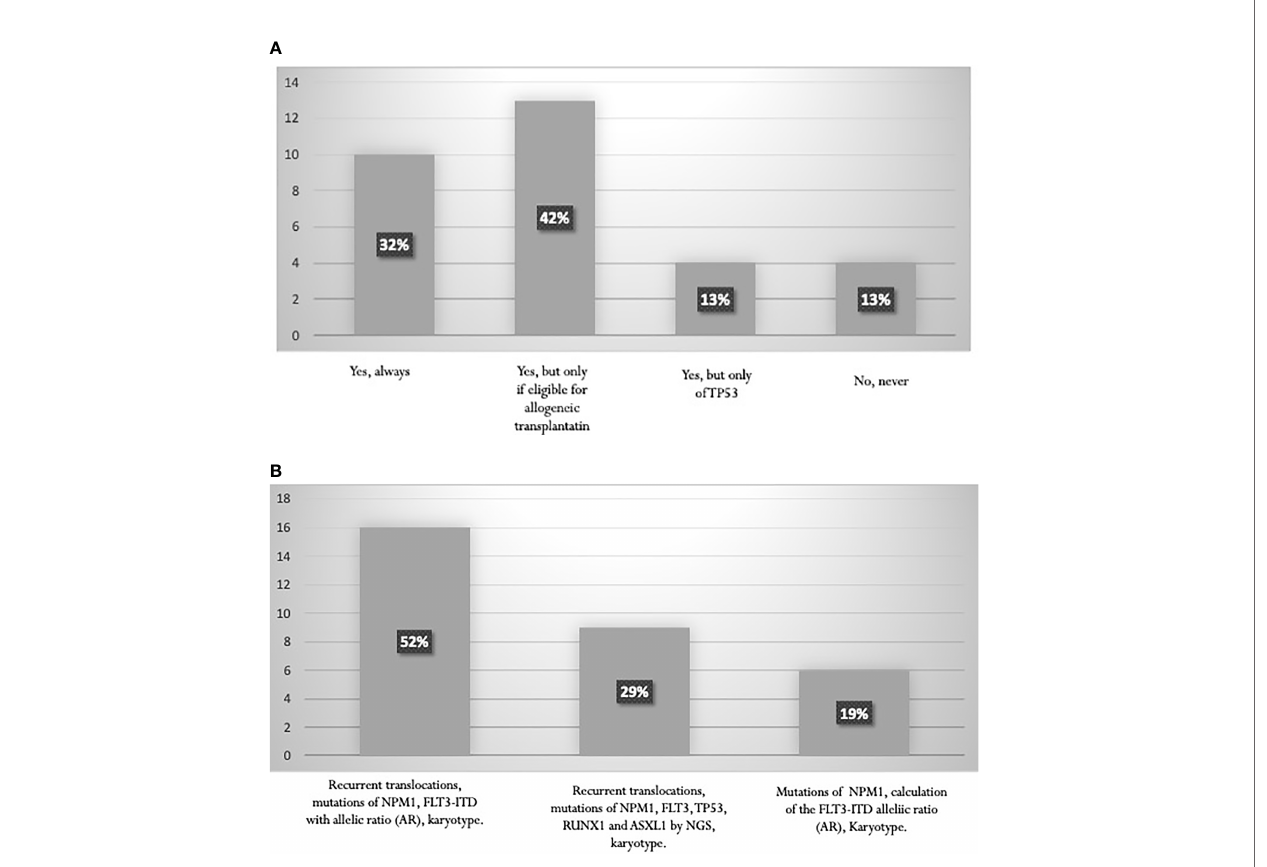
FIGURE 3 | (A) Proportion of laboratories performing RUNX1, ASXL1, TP53 mutation studies. (B) Tests performed for AML strati fi cation according to ELN